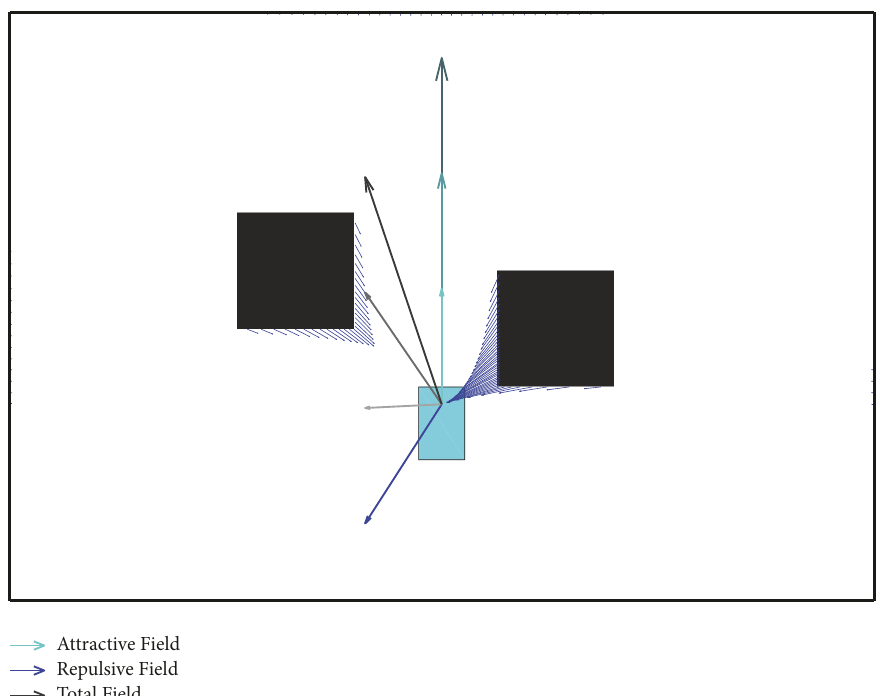
Figure 22: Total field of PFM and AFPFM with varying 𝑘 𝑎𝑡𝑡 .